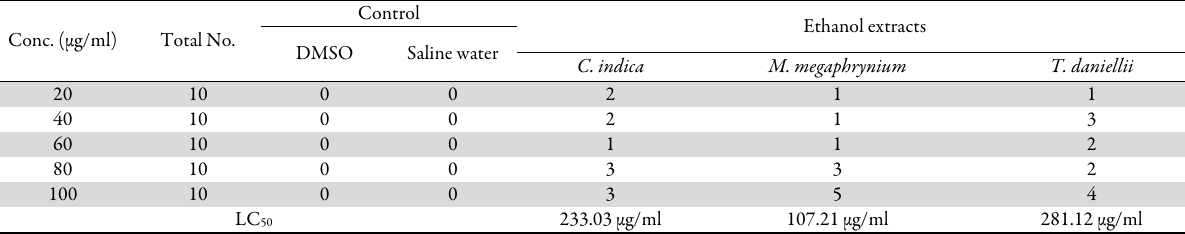
Table 3. Cytotoxicity assay of leaf extracts of test plants on Brine shrimp Conc. (µg/ml) Total